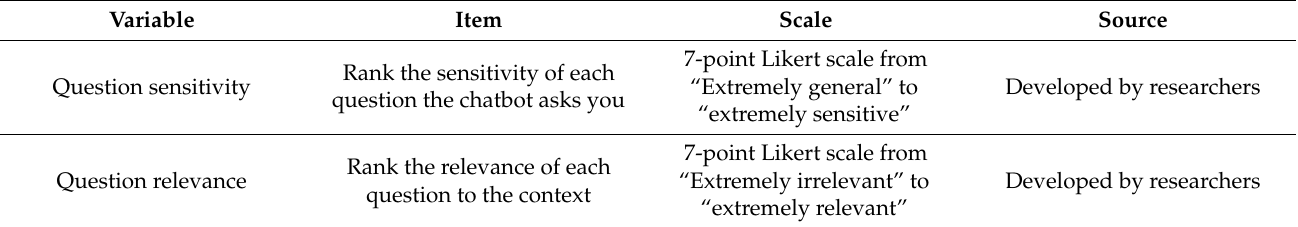
Table 1. Pre-test Variables